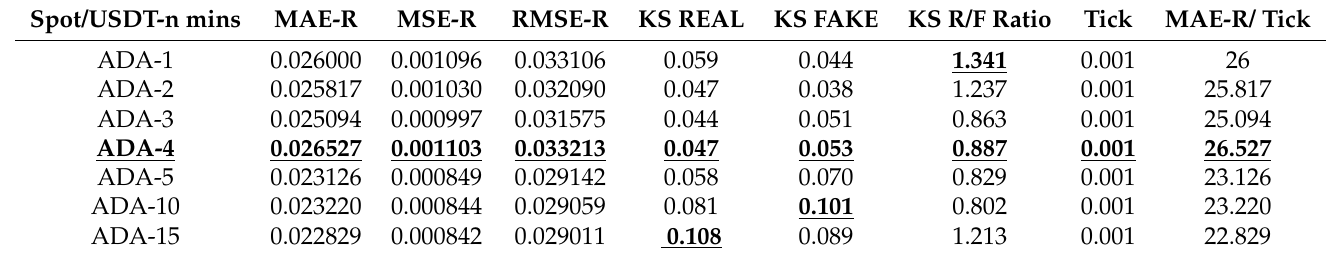
Table 12. We examined ADAUSDT spot prices against generated prices at one, two, three, four, five, ten and fifteen minute intervals. For KS R/F Ratio, two out of seven are more significant than one, where the highest KS REAL and FAKE are 0.108 and 0.101.